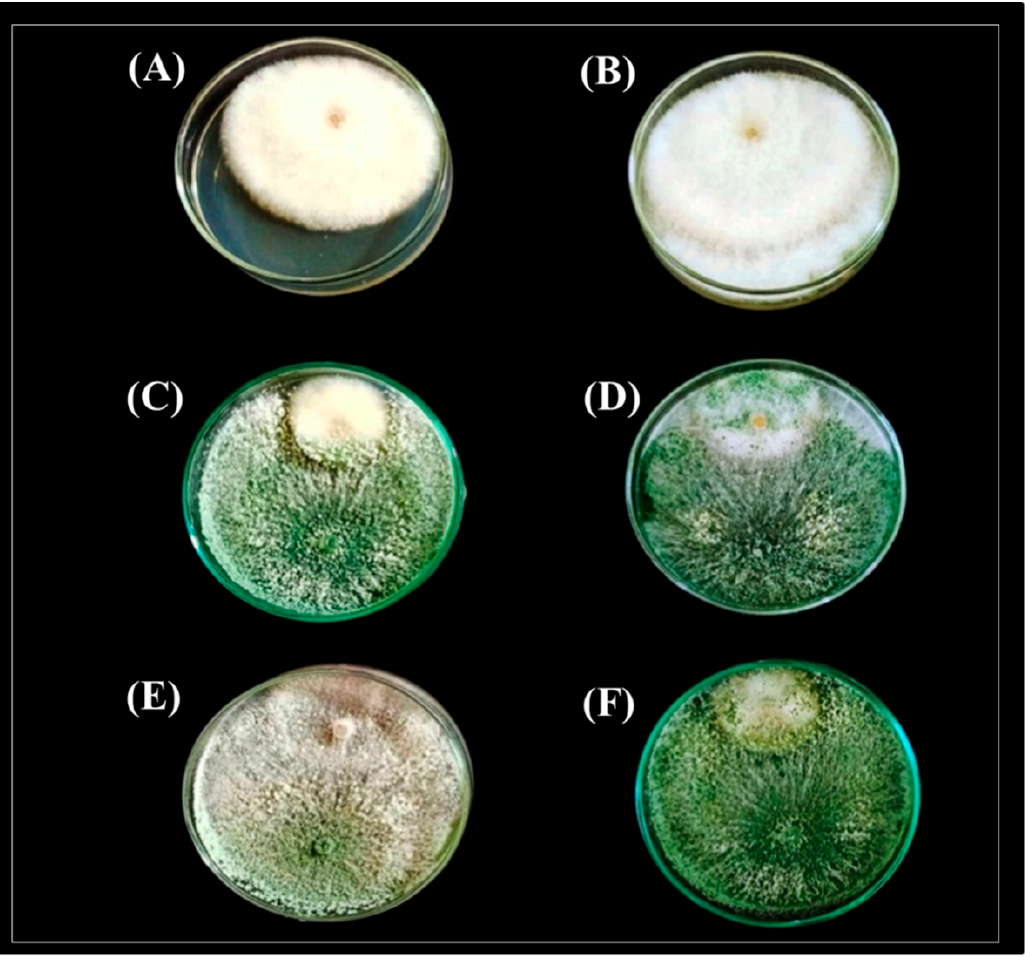
Figure 2. The dual culture assay showing in vitro mycoparasitic and antagonistic activity of Trichoderma spp. ( T. viride and T. harzianum ) against the pathogen F. solani (inoculated simultaneously). ( A , B ) F. solani inoculated alone as control, ( C , D ) mycoparasitic activity of T. viride against F. solani , ( E , F ) mycoparasitic behavior of T. harzianum against F. solani , ( A , C , E ) pictures taken 5 days post-inoculation, and ( B , D , F ) pictures taken 10 days post-inoculation.